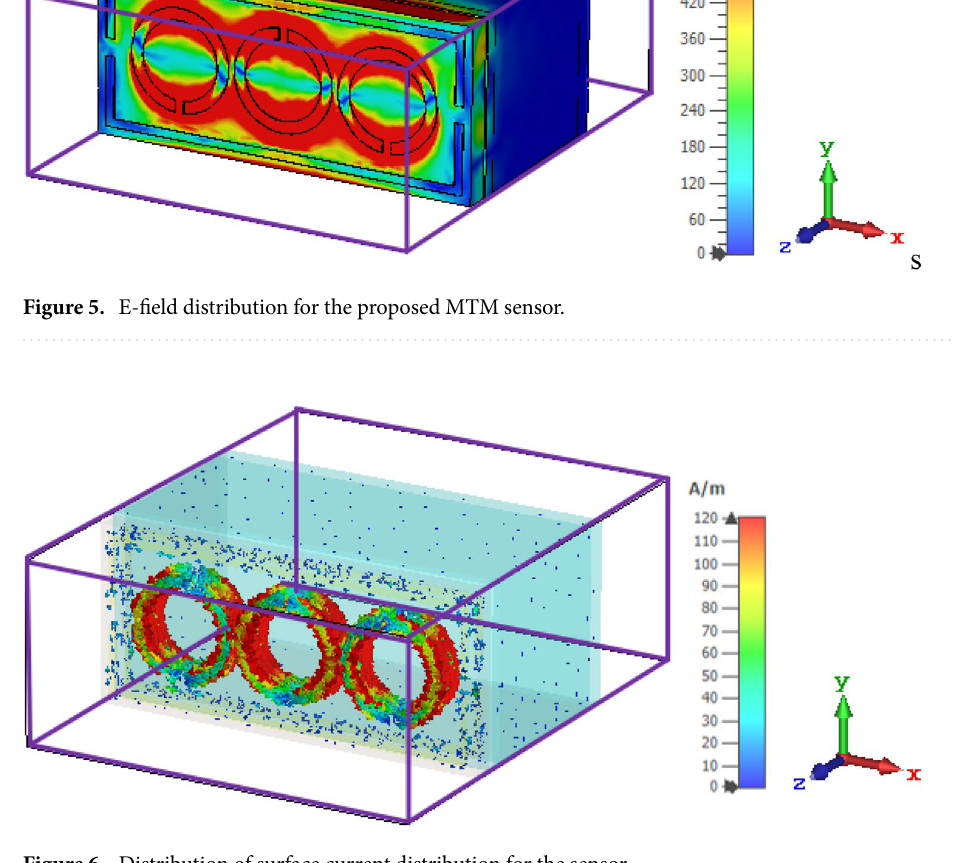
Figure 6. Distribution of surface current distribution for the